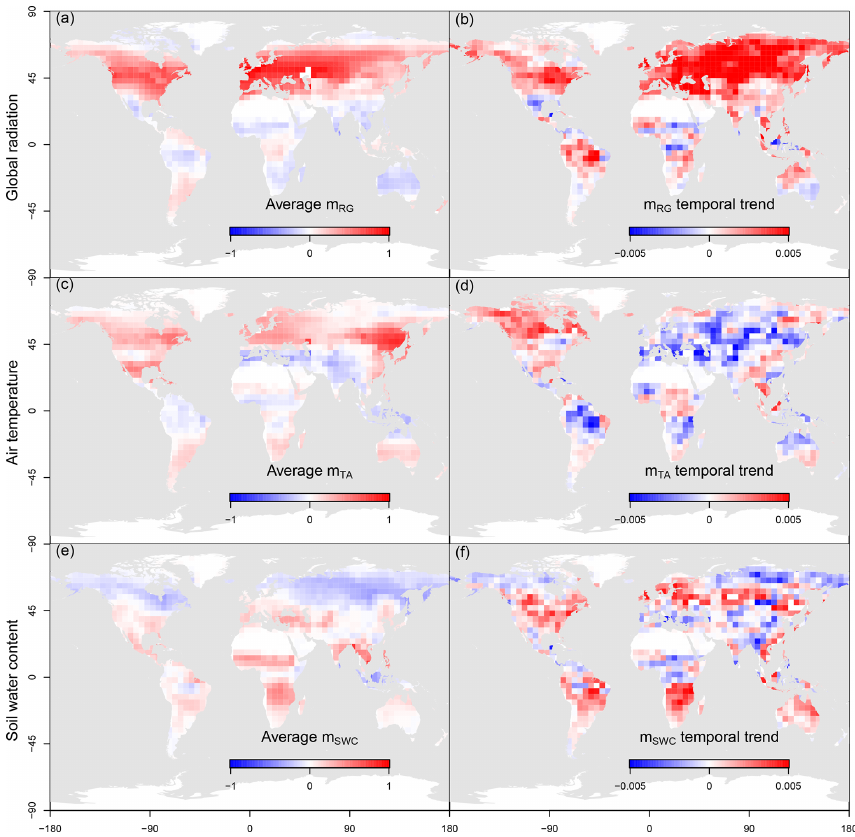
Figure 4. Maps of magnitude (a, c, e) and trends (b, d, f) of the sensitivity of net biome productivity (NBP) to global radiation (a, b) , air temperature (c, d) and soil water content (e, f) at a weekly